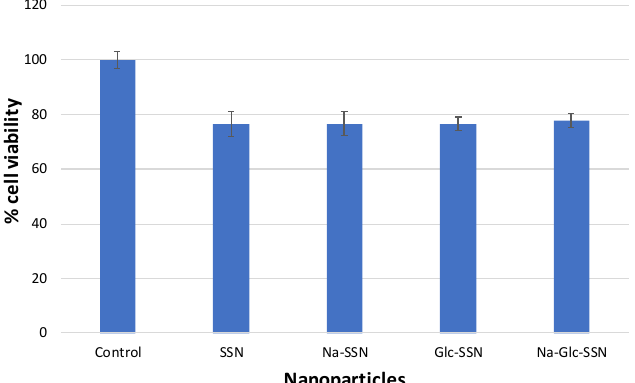
Figure 13. Cell viability assessment of different strontium sulfite particles formed with or without NaCl and D -glucose. MCF-7 cells were seeded and treated with SSNs (60mM SrCl 2 and 10 mM of Na 2 SO 3 , Na-SSN(60 mM SrCl 2 , 10 mM of Na 2 SO 3 and 300 mM of NaCl), Glc-SSN (60 mM SrCl 2 , 10 mM of Na 2 SO 3 and 200 mm of D -glucose) and Na-Glc-SSN (60 mM SrCl 2 , 10 mM of Na 2 SO 3, 300 mM of NaCl and 200 mm of D -glucose).